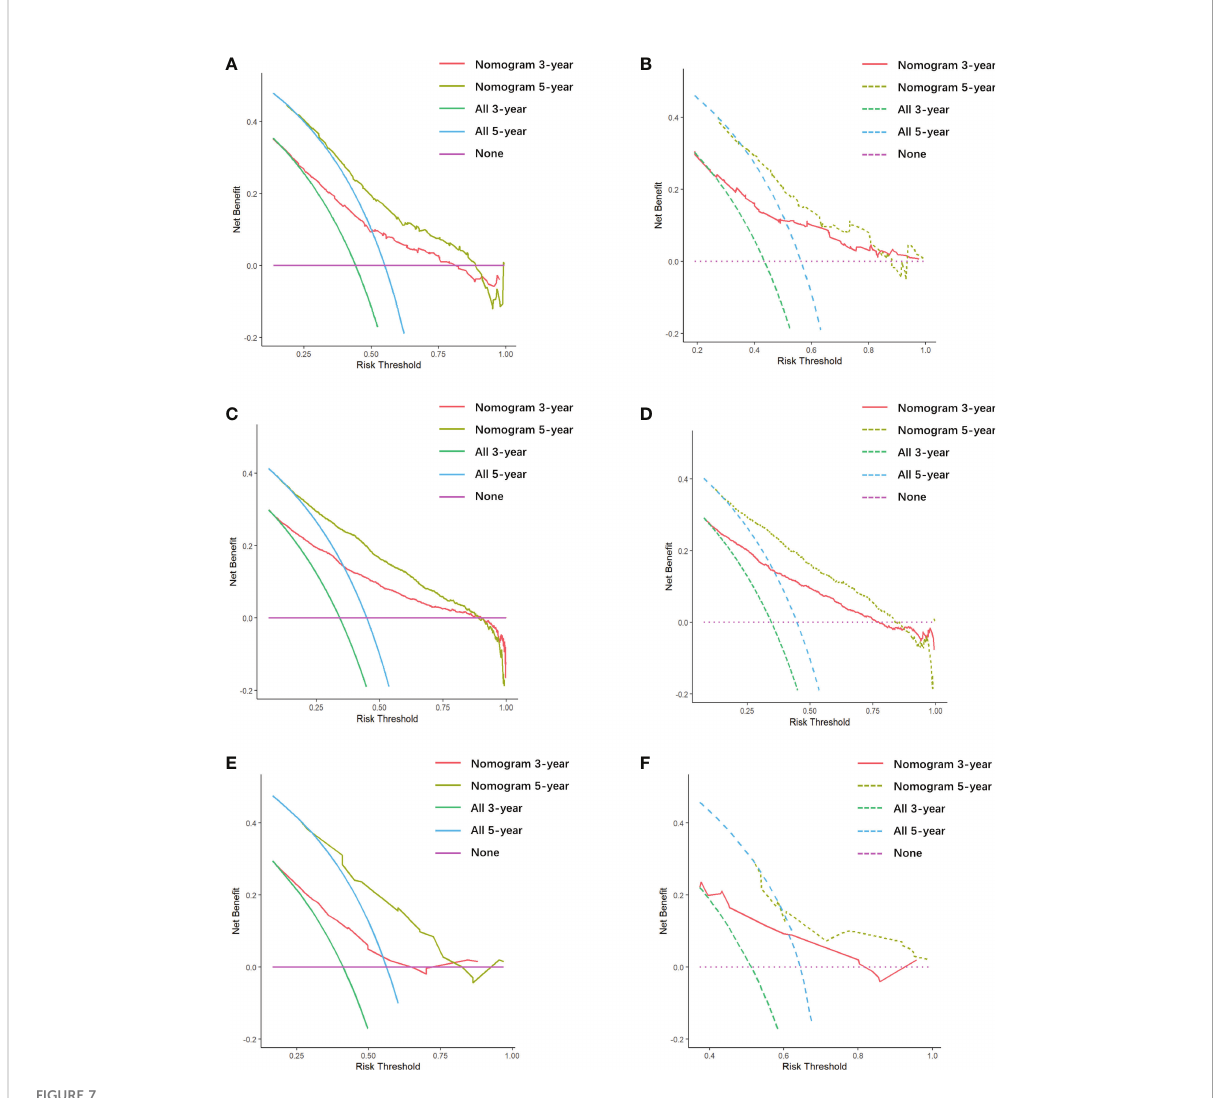
FIGURE 7 Decision curve analysis (DCA) of all cohorts. (A) DCA of the fi rst cohort training set. (B) DCA of the fi rst cohort validation set. (C) DCA of the second cohort training set. (D) DCA of the second cohort validation set. (E) DCA of the third cohort training set. (F) DCA of the third cohort validation